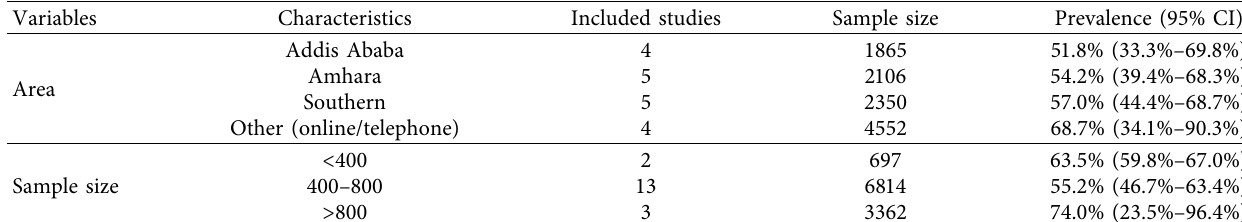
Table 2: Level of COVID-19 vaccine acceptance by study area and sample size.